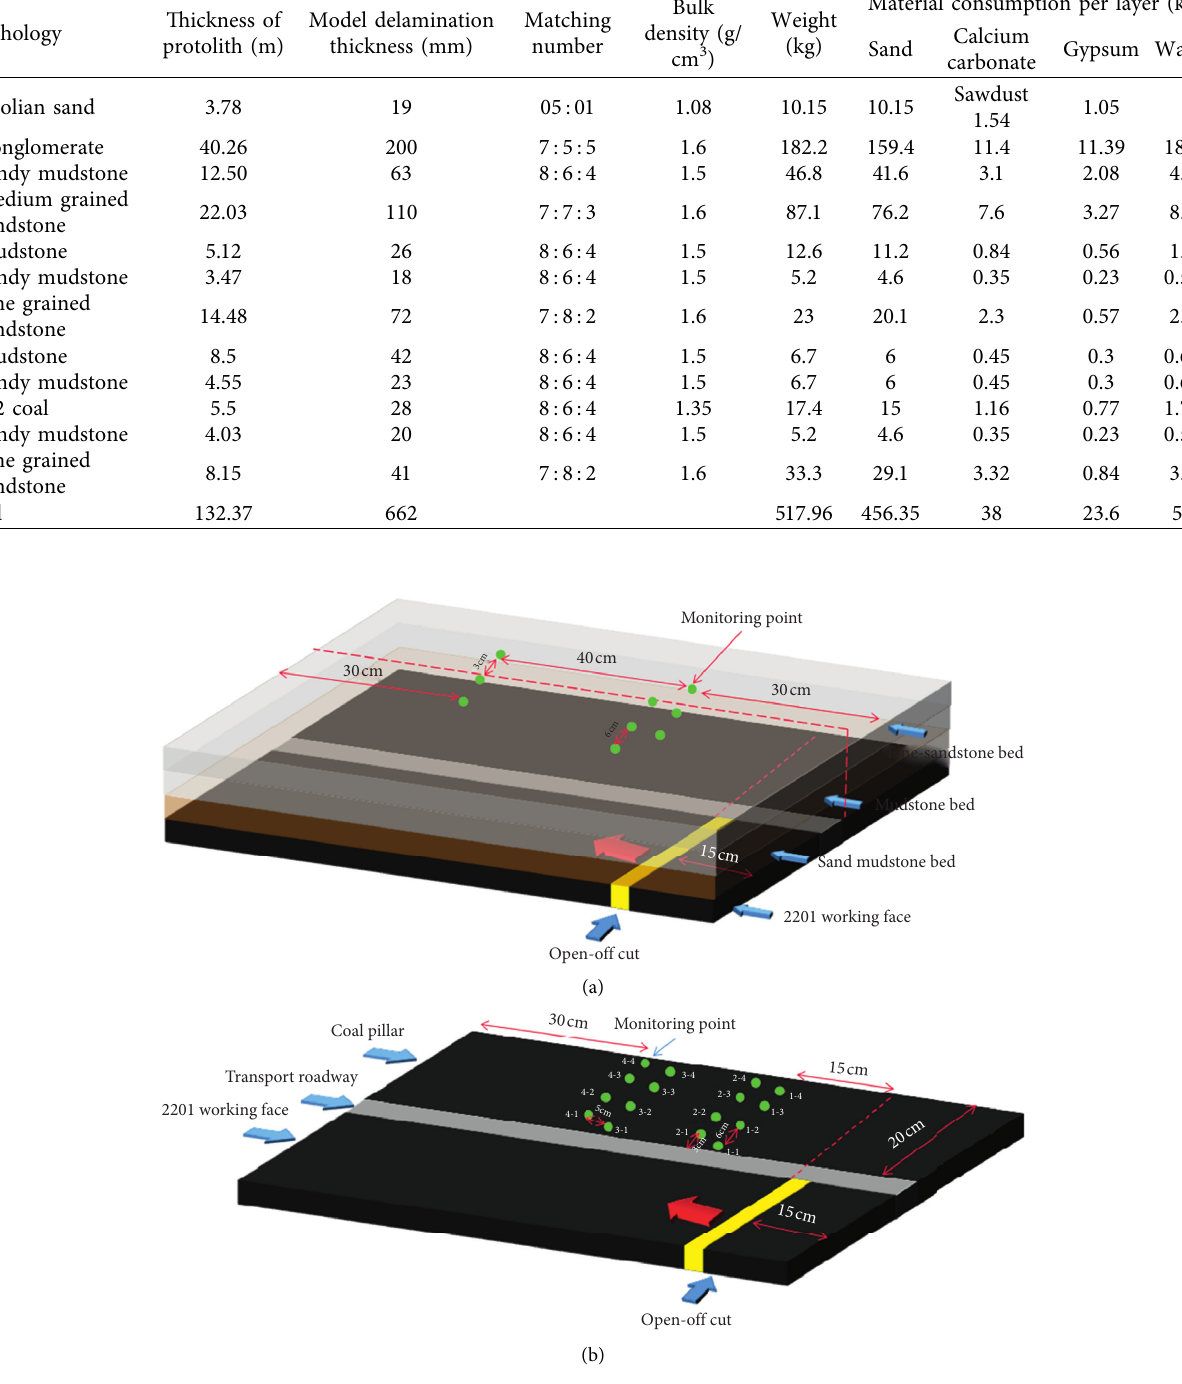
Figure 4: Layout of measuring points for similar material